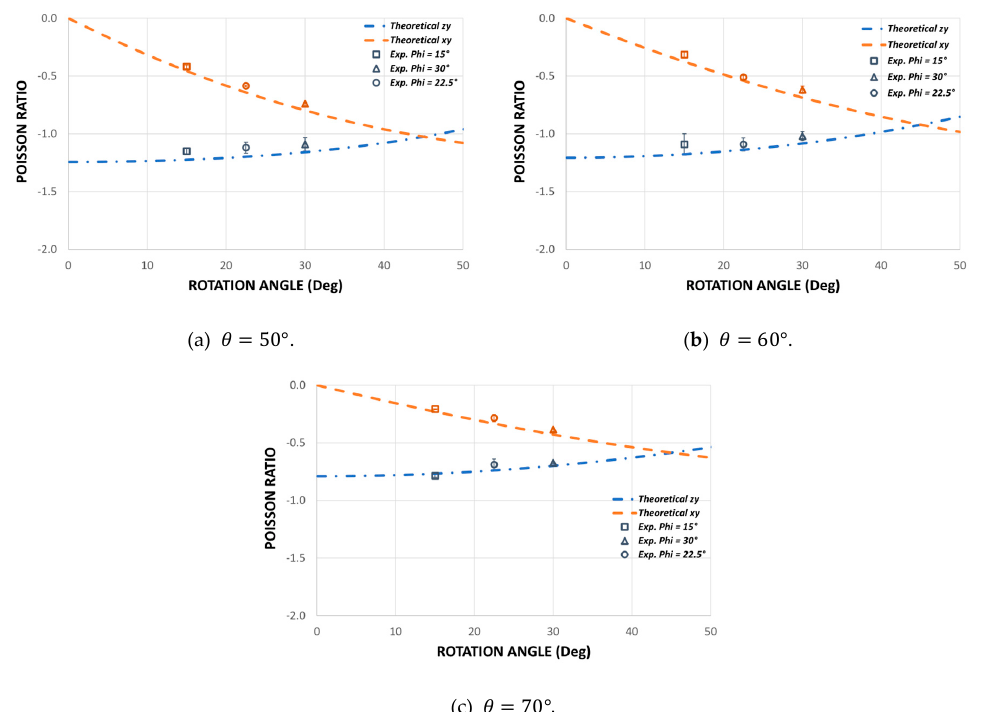
Figure 10. Comparison of the theoretical Poisson’s ratio vs. the experimental Poisson’s ratio for each macrostructure for different values of the re-entrant angle θ = { 50 ◦ ;60 ◦ ;70 ◦ } and for different values of the design parameter ∅ .